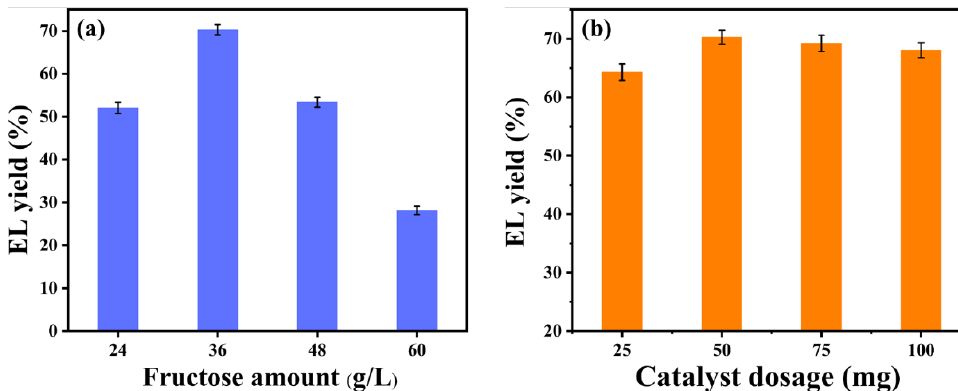
Figure 8. Effects of ( a ) fructose amount (catalyst 50 mg, ethanol 5 mL, 130 °C, 10 h) and ( b ) catalyst dosage (fructose 180 mg, ethanol 5 mL, 130 °C, 10 h) on EL yield.